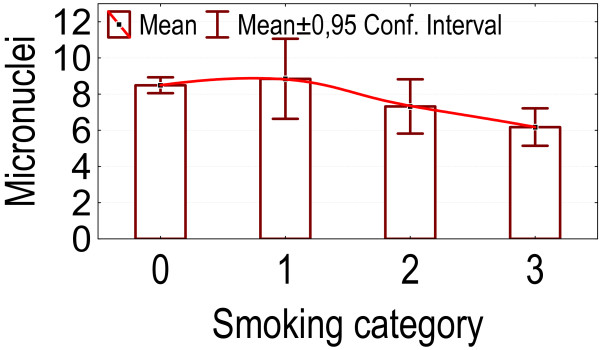
Different smoking categories: association with the number of micronuclei. Category 0: non-smokers; category 1: persons smoked less than 100,000 cigarettes; category 2: persons smoked at least 100,000 but less than 200,000 cigarettes; category 3: persons smoked at least 200,000 cigarettes.